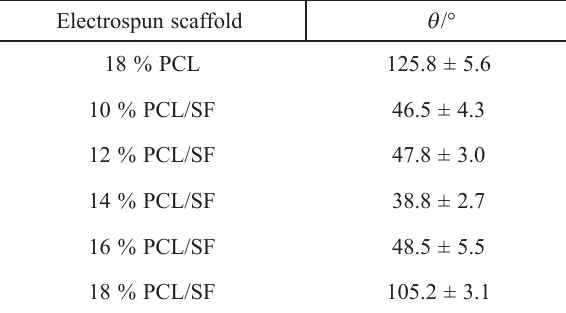
Table 1 – Water contact angle measured on the surface of the electrospun